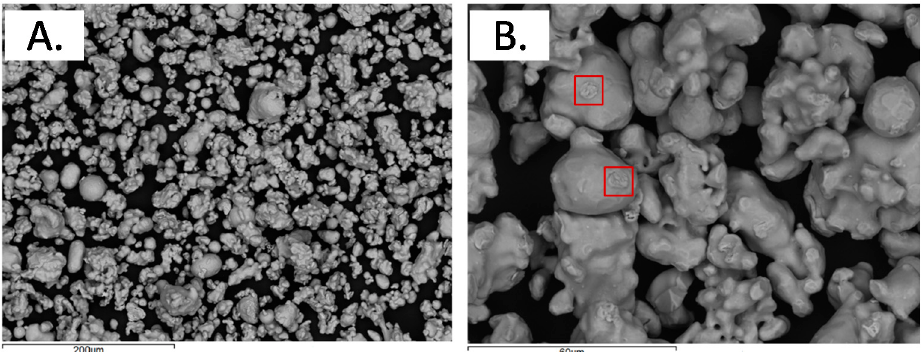
Figure 6. SEM micrographs of the water-atomized diffusion-bonded/diffusion-alloyed FC-0208 powders ( A ) 250× and ( B ) 1000×.